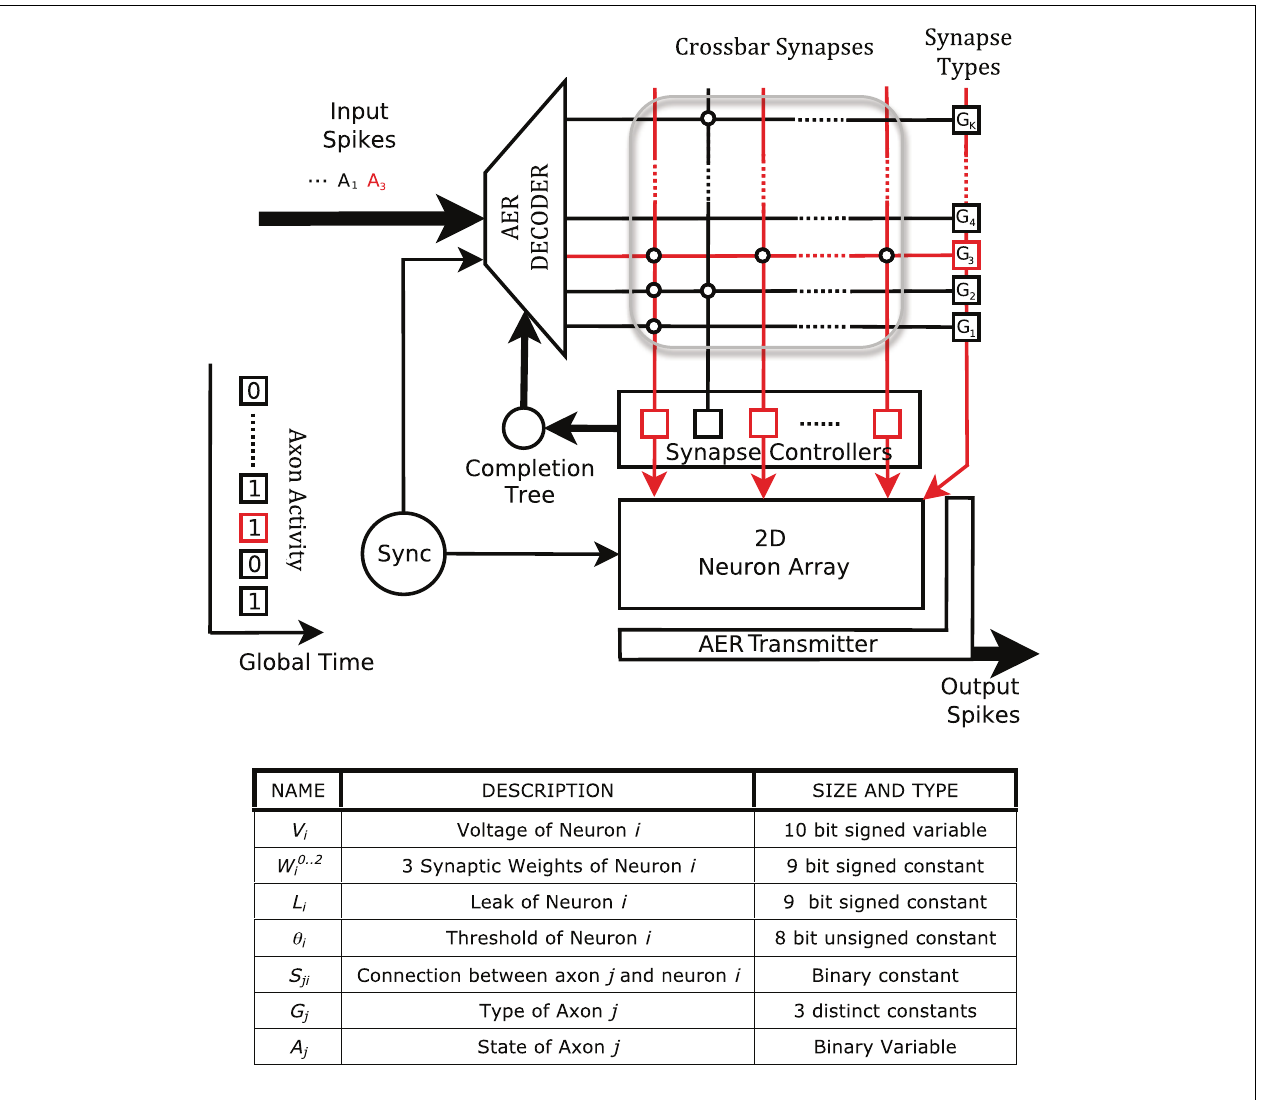
decoder accepts an incoming address event and activates axon 3 (A3) by asserting the third wordline of the SRAM crossbar array. As a result, a synaptic event of type G3 is delivered to neurons N1, N3, and NM.The AER transmitter sends out the addresses of these neurons if they consequently spike. Bottom: Parameters and state variables of the